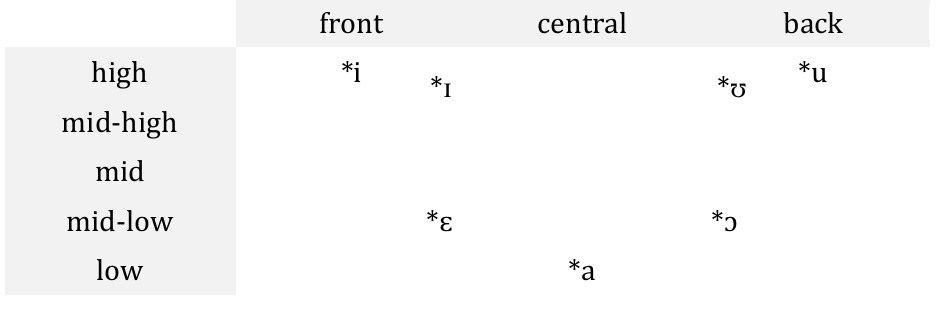
Table 2 : The PB vowel system